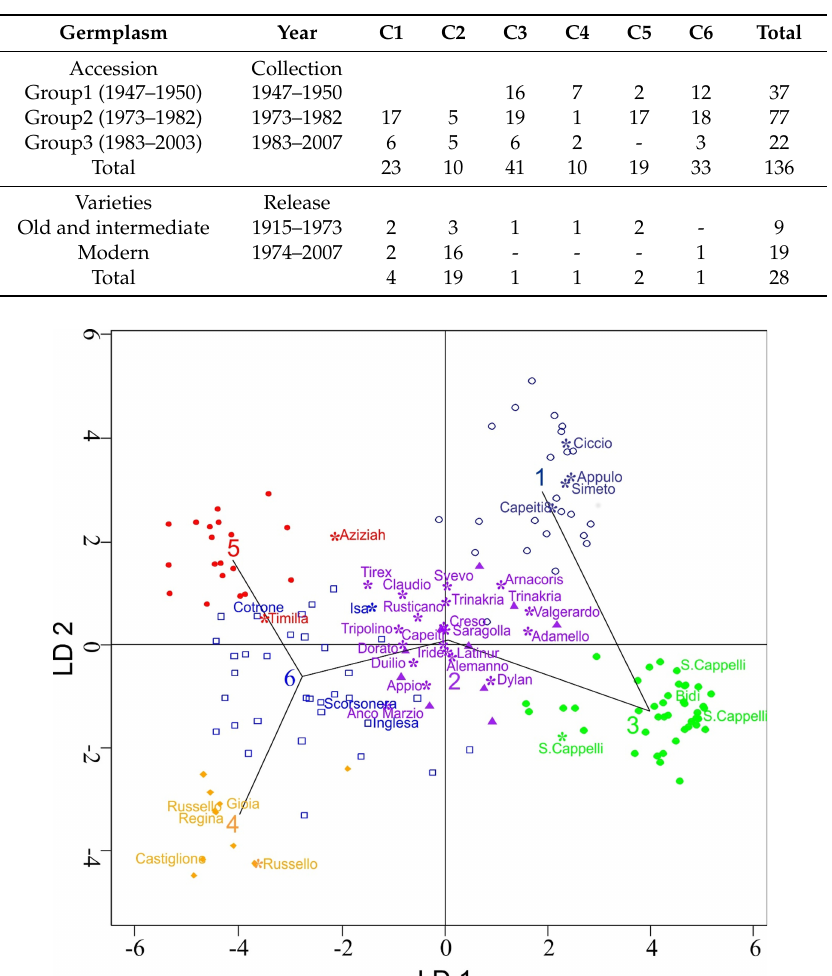
Table 2. Number of accessions per collection year and varieties per year of release in six clusters obtained by discriminant analysis of principal components (DAPC) for 136 ex situ accessions and 28 durum wheat varieties.